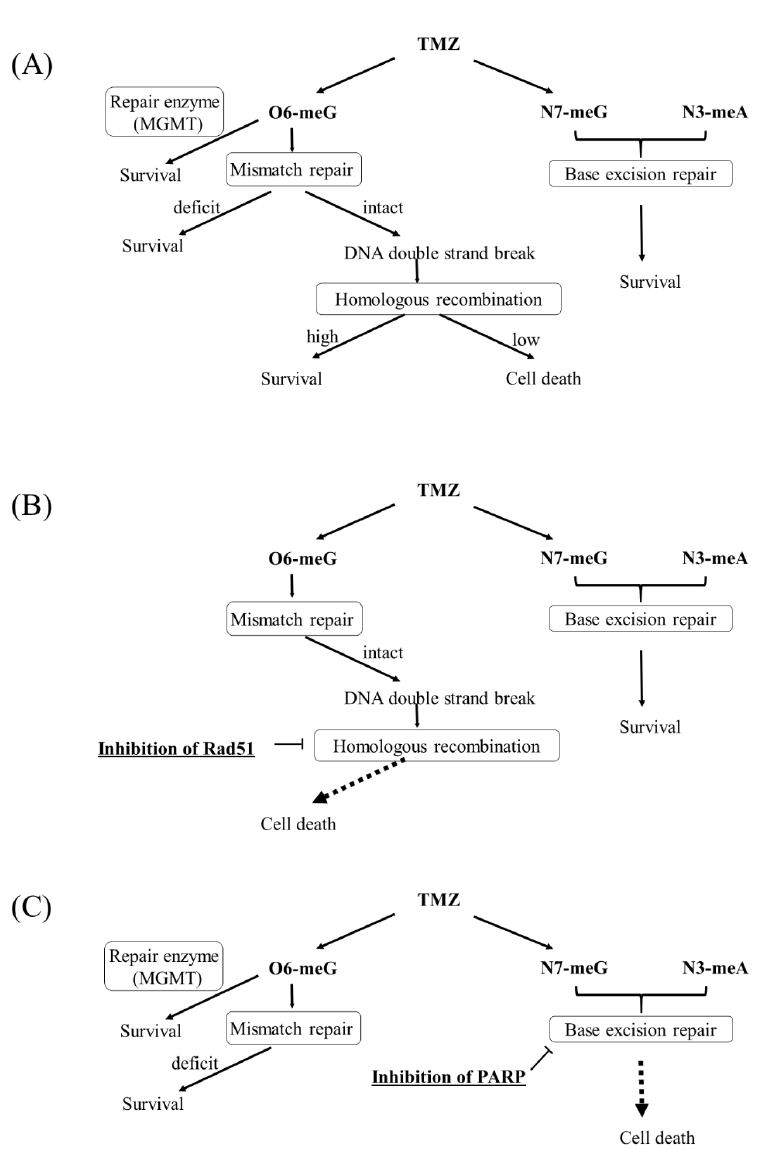
Figure 8. Mechanisms of resistance to temozolomide and methods to overcome the resistance. ( A ) Mechanisms of TMZ-induced DNA damage and mechanism of resistance to the action ( B ) The way to overcome TMZ-resistant cells due to increased homologous recombination. Inhibition of homologous recombination sensitize the cells to TMZ if MGMT is absent and MMR is intact. ( C ) The way to overcome TMZ-resistant cells due to MMR deficiency or high-expressed MGMT. Inhibition of PARP suppresss base excision repair that restore TMZ-induced N7-meG and N3-meA, which leads cell